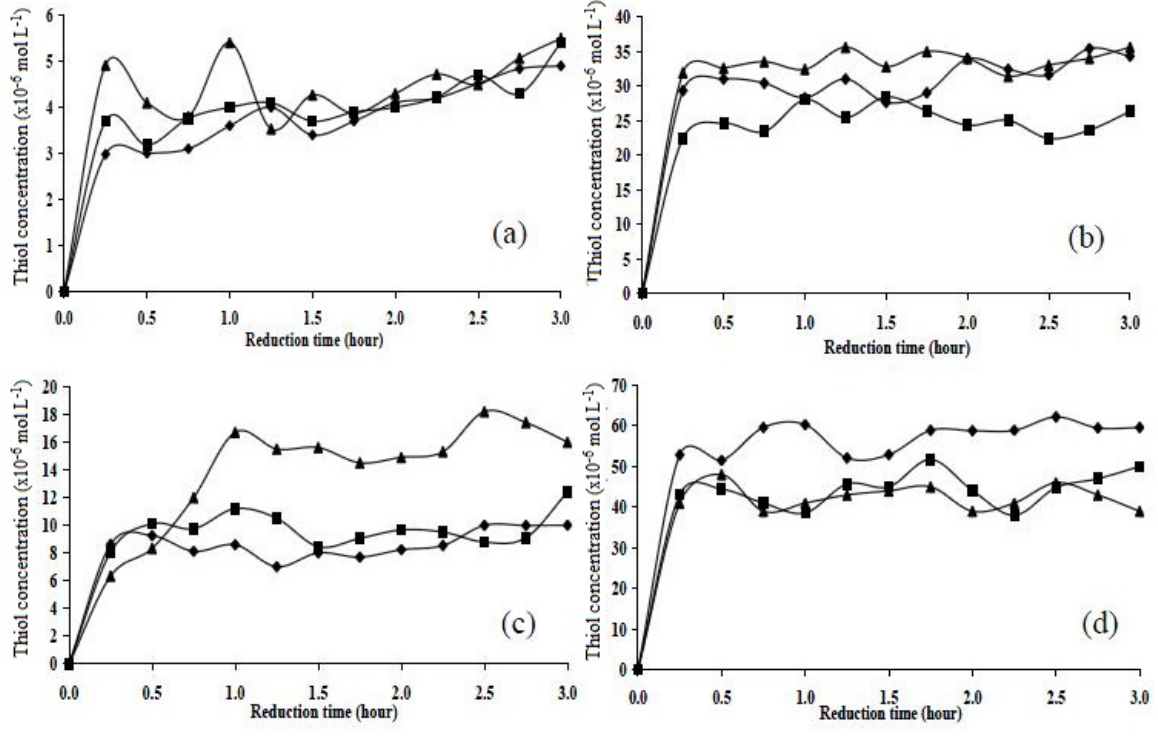
Figure 5. Chemical reduction of polymers ( a ) P10; ( b ) P11; ( c ) P151; and ( d ) P15 using zinc/acetic acid in three batches ( ♦ batch 1, ■ batch 2, ▲ batch